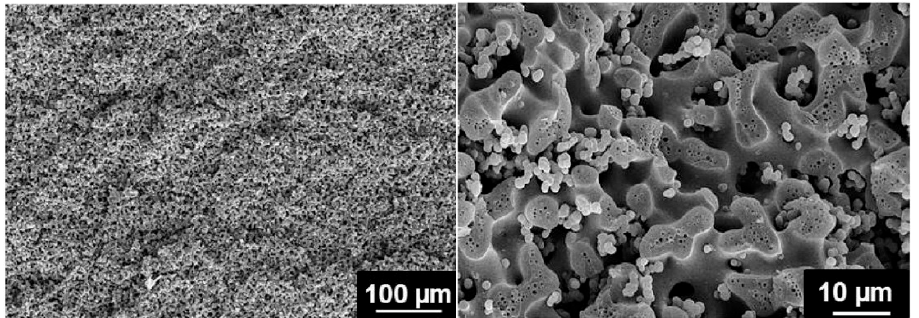
Figure 21. MTM57 50% with 4.6 mol/L of LiTFSI SEM micrographs with a more homogeneous biphasic microstructure from Shirshova et al. [80]. Table 3 Structural polymer electrolytes properties. Ref.79